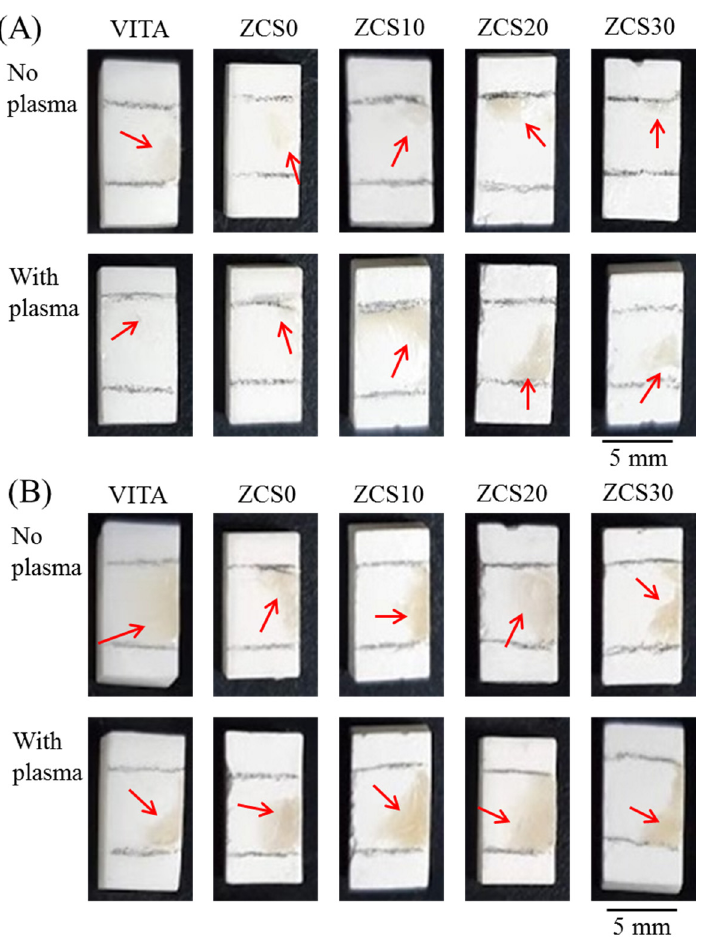
Figure 7. Fracture images of ( A ) IPS e.max Ceram and ( B ) VITA VM9 veneering ceramics bonded to the surface of various core specimens after shear bond testing. The two lines represent the contact zone of the core-veneer bonding before failure. The arrow indicates the remaining veneering ceramics.